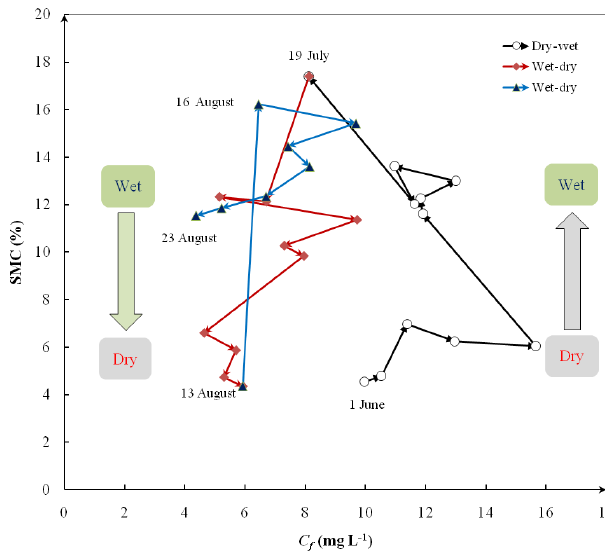
Figure 7. The changes of event-driven C f (flow-weighted mean concentration) response to dry–wet and wet–dry variations in soil moisture